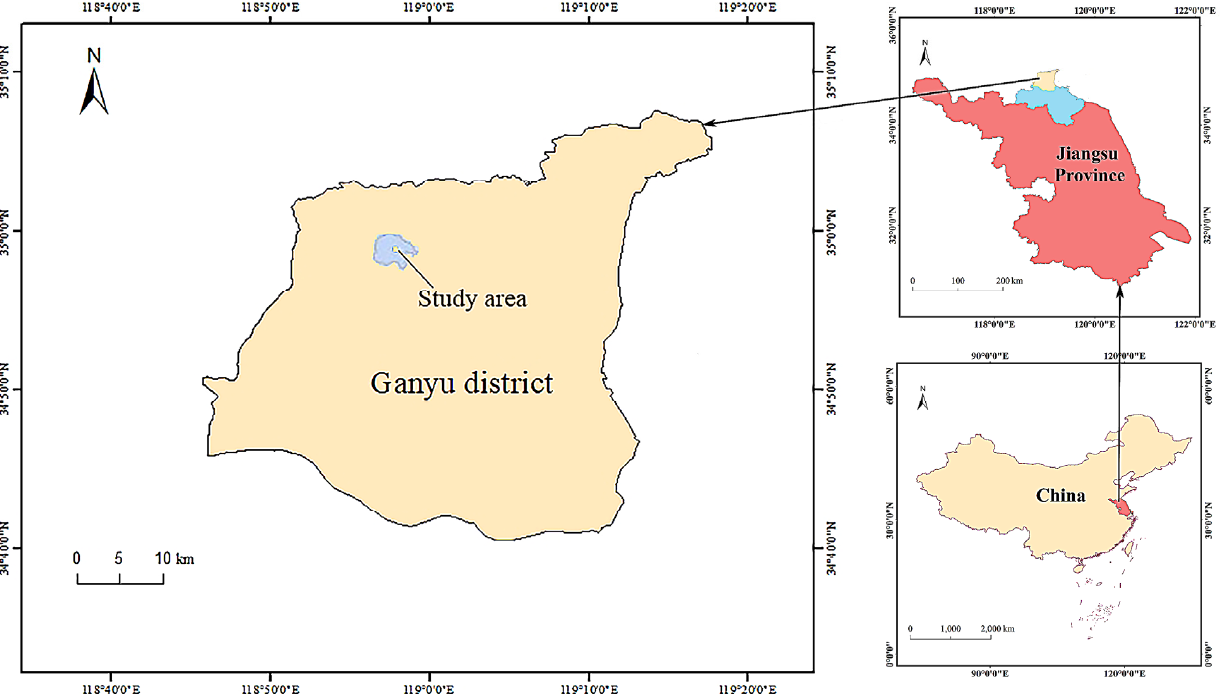
Table 2. Soil physicochemical properties of different forest types.